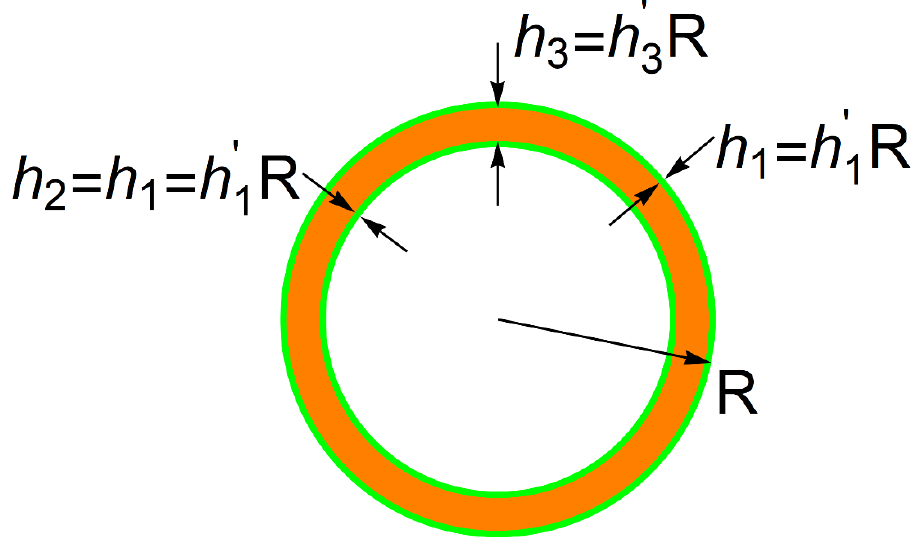
Figure 2. Dimensions of a spherical sandwich shell (not to scale; note that, e.g., ℎ (cid:2871) ≫ ℎ (cid:2869) for the optimal design).